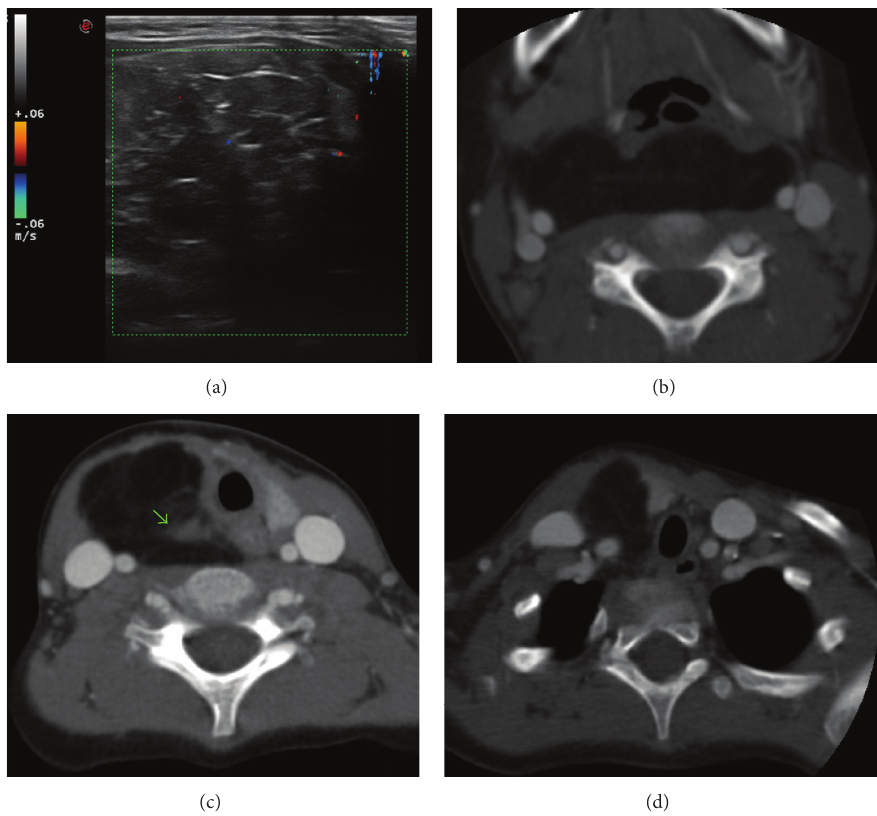
Figure 2: (a) US color-Doppler evaluation revealed low vascularity of the tumor. CT scan showed the extent of the fatty mass in (b) retropharyngeal space displacing the right vascular bound, (c) along the right side of the trachea, where along the right side of the trachea where an enhanced solid nodule (arrow) was appreciable an enhanced solid nodule (arrow), and (d) up to right supraclavicular